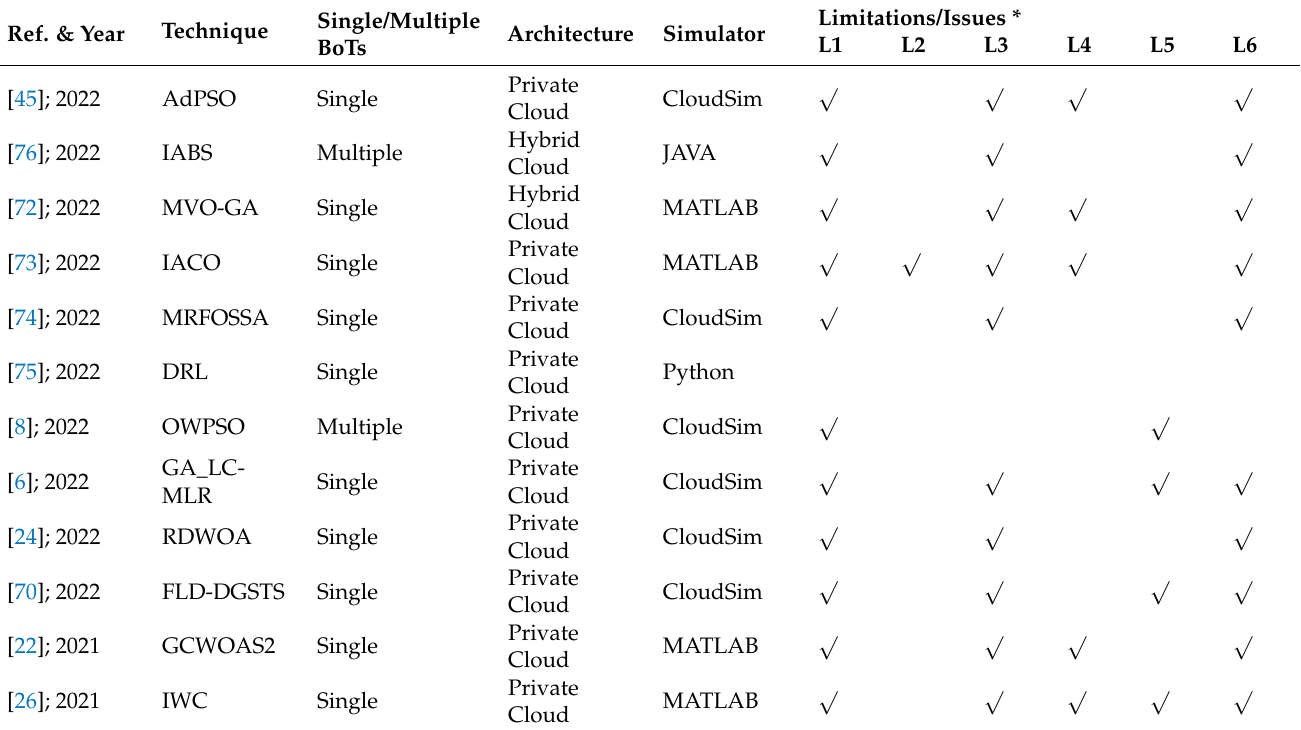
Table 2. Limitations and issues of recent cloud scheduling techniques. Ref. &